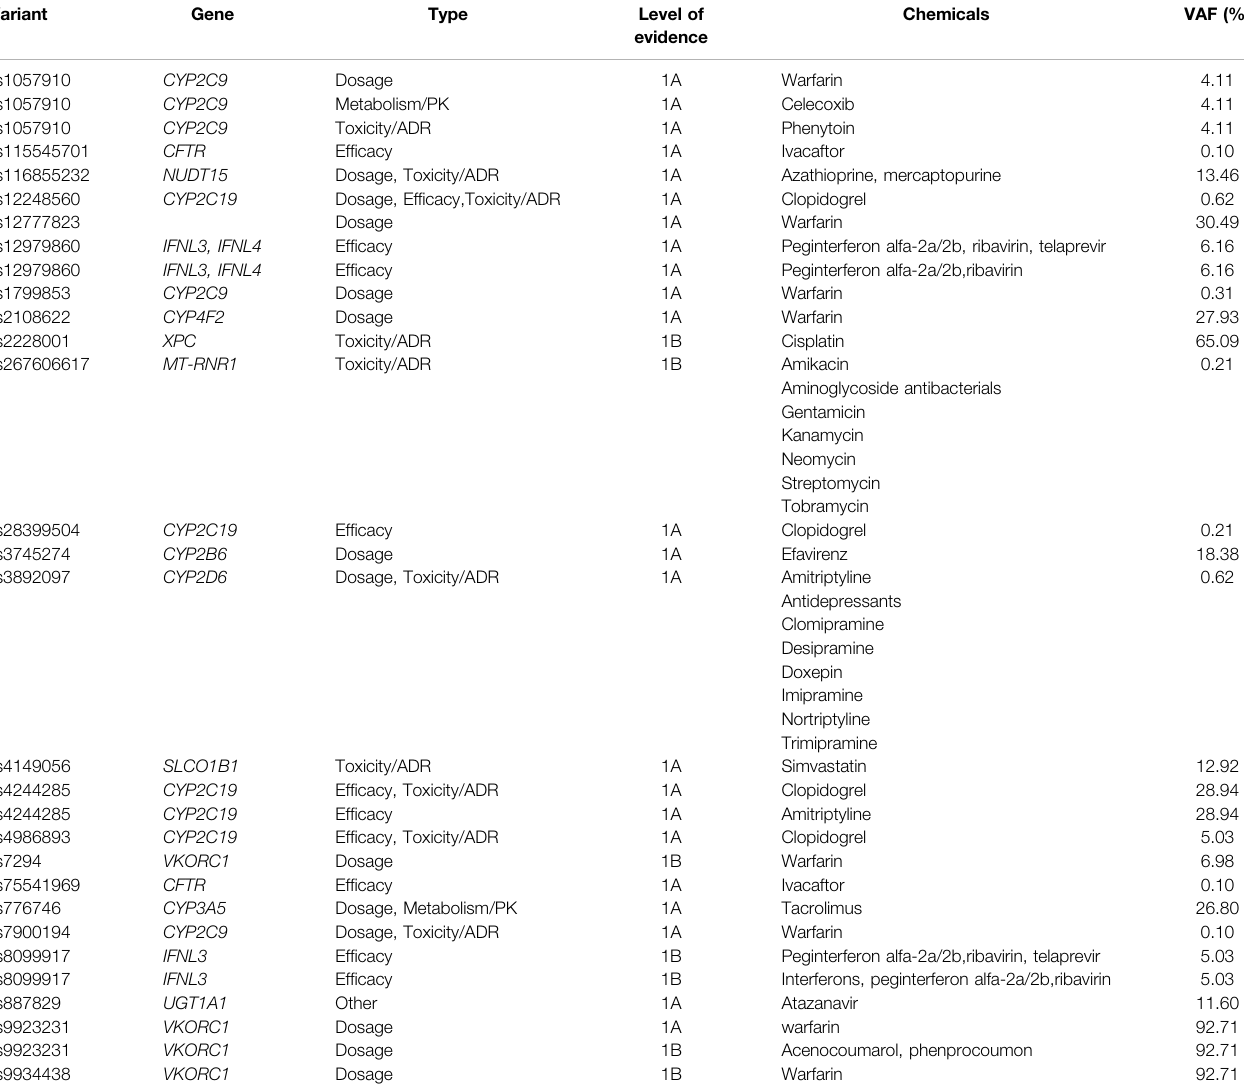
TABLE 3 | Clinical annotations of 30 variants with a higher level of evidence (Level 1A and 1B) in PharmGKB.